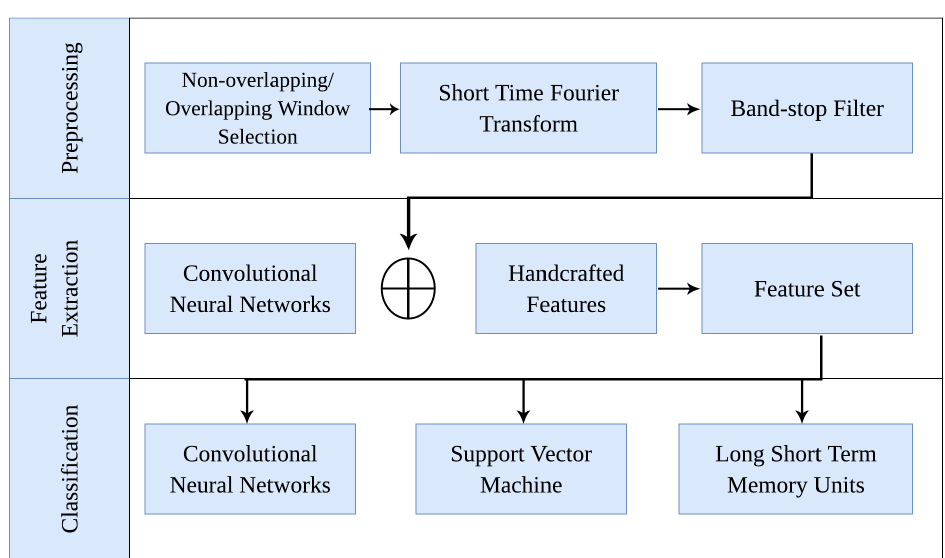
Figure 2. Flow diagram of the proposed epilepsy prediction system.